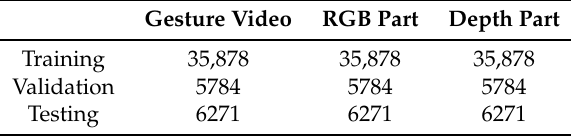
Table 2. Statistical information of IsoGD dataset.